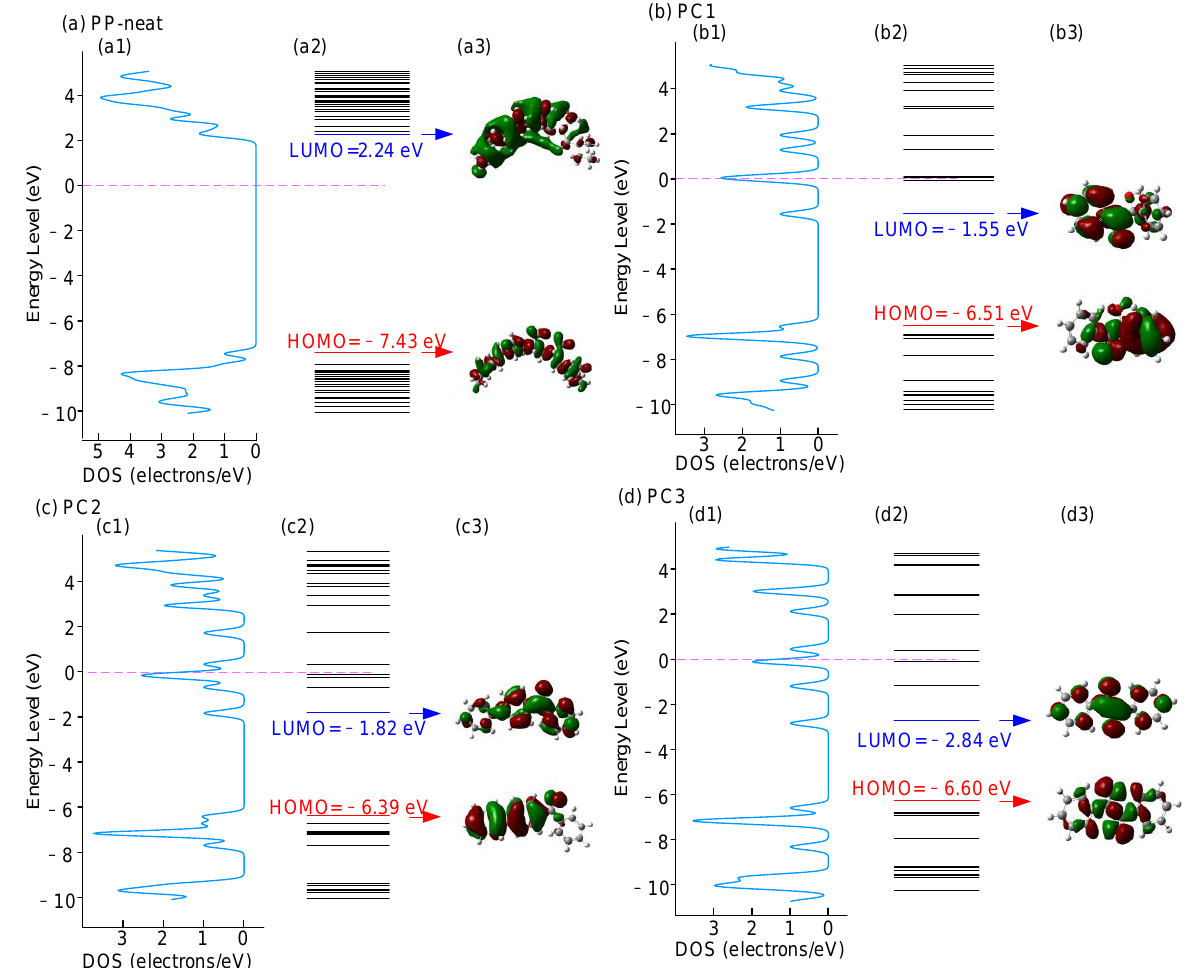
Figure 8. DOS, energy level distribution, and molecular orbitals (MOs) of the samples: ( a1 – d1 ) DOS, ( a2 – d2 ) energy level distribution, and ( a3 – d3 ) MOs.